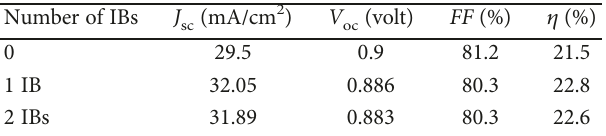
, V , FF , and η for 0, 1, and 2 sc oc